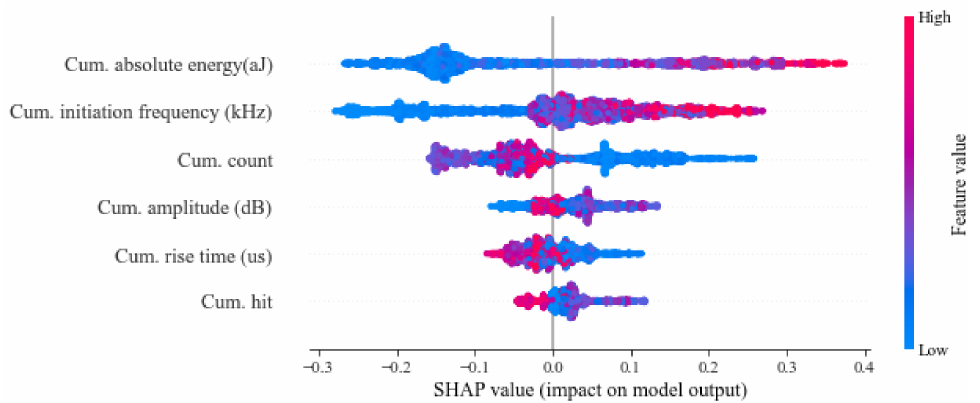
Figure 12. Distribution of SHAP values for cumulative AE parameters. An individual point repre- sents the SHAP value of each dataset. The higher the SHAP value, the higher the positive contribution to the damage value. On the other hand, the lower the SHAP value, the higher the negative con- tribution to the damage value. The degree of ‘high’ and ‘low’ values for the parameter can be distinguished by colors ‘red’ and ‘blue’,